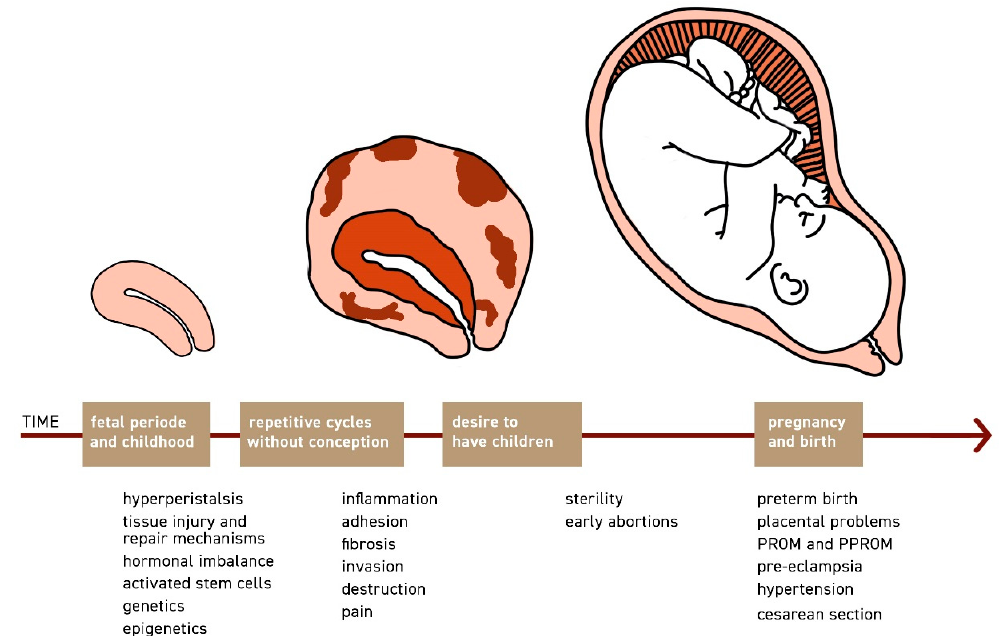
Figure 1. Women with archimetrosis develop functional and structural changes of the uterus over time. When the desire to have children arises the uterine function may be impaired and symptoms such as sterility and early abortions are commonly observed. Even if pregnancy is achieved sponta- neously, or more likely with the help of IVF, it may be associated with complications such as preterm birth, placental problems, early rupture of membranes, pre-eclampsia, hypertension, and a higher rate of